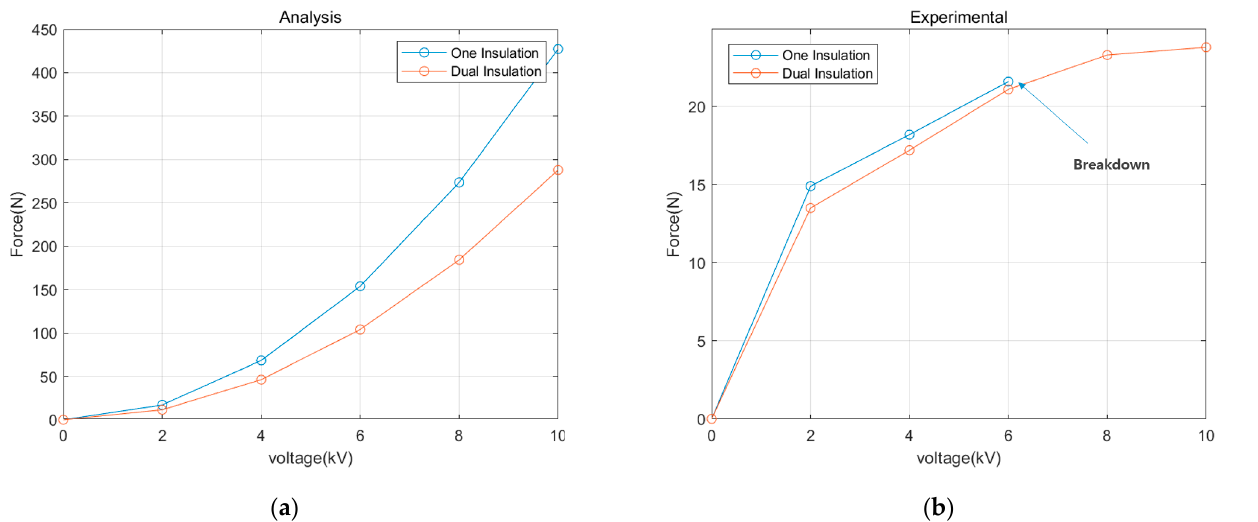
Figure 2. Comparison of experimental and analysis data of the single-insulation pad structure and the dual-insulation pad structure electroadhesion pad: ( a ) analysis data; ( b ) experimental